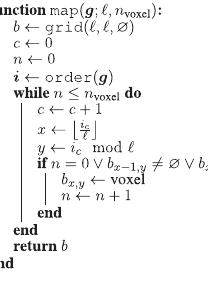
Frontiers in Robotics and AI |